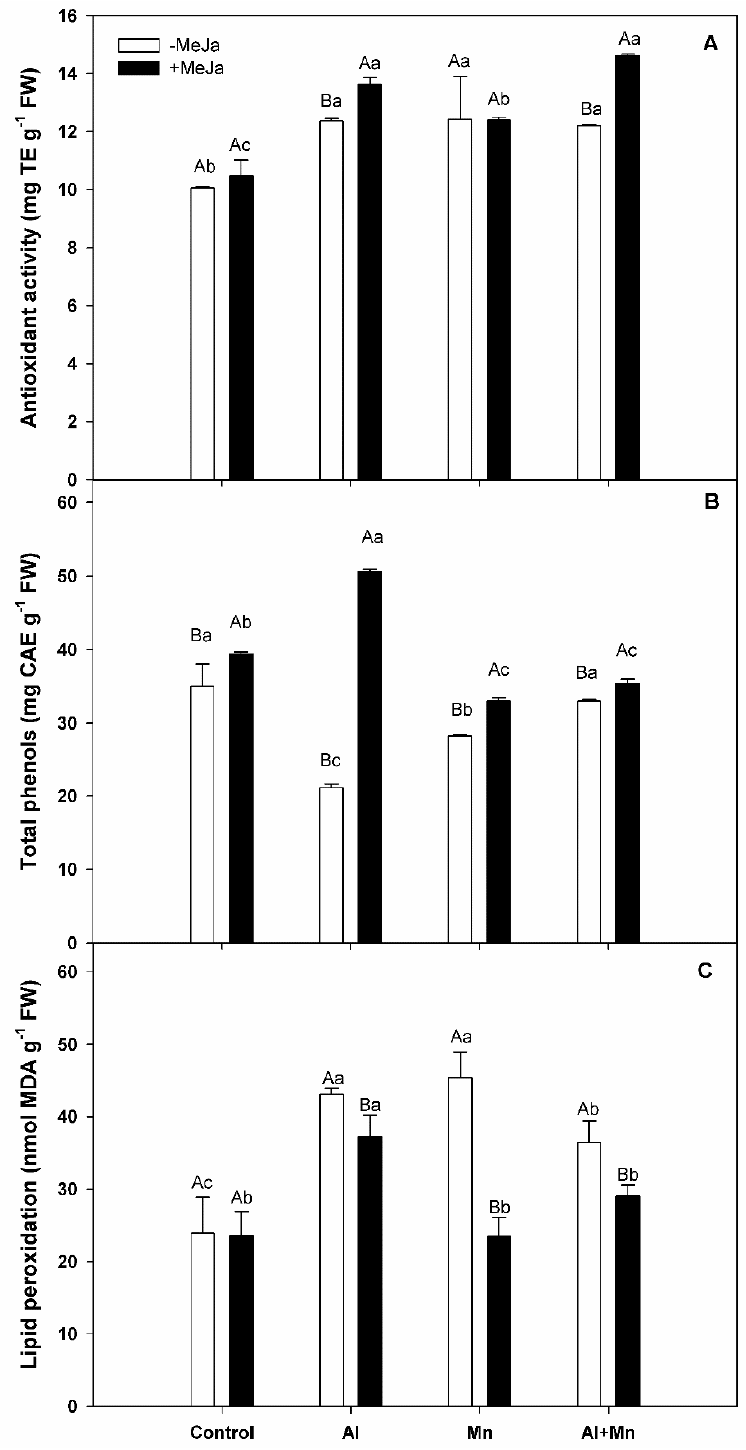
Figure 4. Antioxidant activity ( A ) and total phenols ( B ), and lipid peroxidation ( C ) in leaves of highbush blueberry cv. Legacy plants subjected to different soil treatments (Al, Mn, and Al–Mn toxicity), and exogenous MeJA. All values represent averages of ten biological replicates ± SE. Different upper-case letters indicate significant differences between MeJA treatments for the same soil conditions according to Tukey’s test ( p ≤ 0.01). Different lower-case letters indicate significant differences among soil conditions for the same MeJA treatment according to Tukey’s test ( p ≤ 0.01).